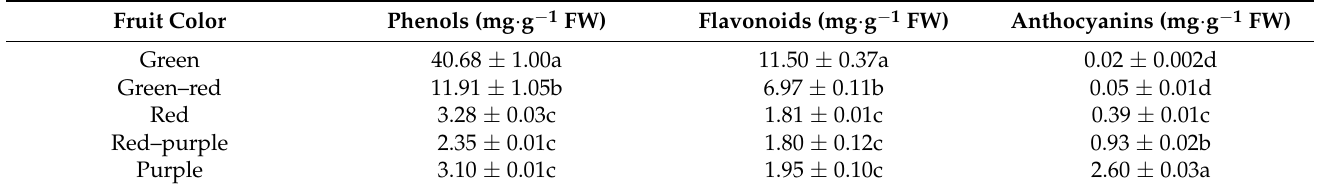
Table 2. Variation in flavonoid, phenol, and anthocyanin contents at different developmental stages in